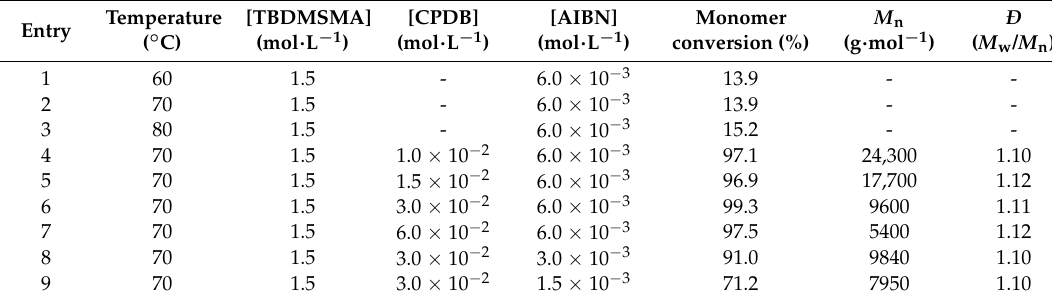
Table 1. Data from the RAFT polymerizations of TBDMSMA in toluene solution.